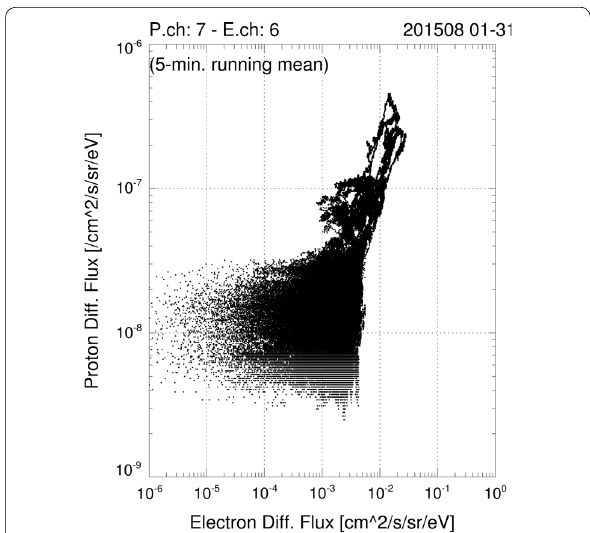
Fig. 4 Scatter plot showing relationship between proton flux (Ch. 7: 81.4 MeV) and electron flux (Ch. 6: 2.0 MeV)